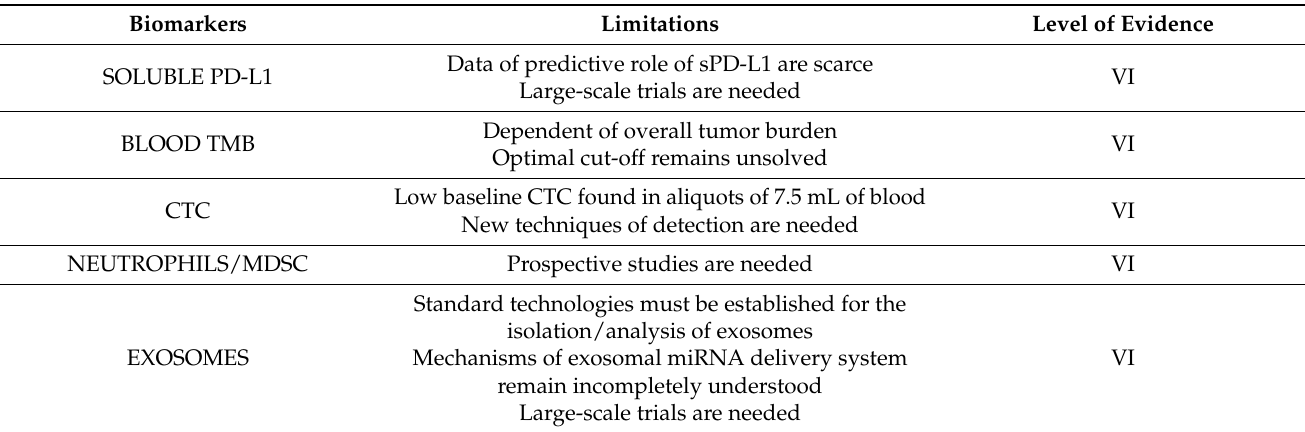
Figure 1. Potential blood biomarkers of clinical benefit in NSCLC patients treated with immunotherapy. Table 1. Potential blood biomarkers of response to ICIs in NSCLC patients. TMB: tumor mutational Table 2. Limitations of blood biomarkers clinical application. Level of evidence VI:Evidence from a single descriptive or qualities